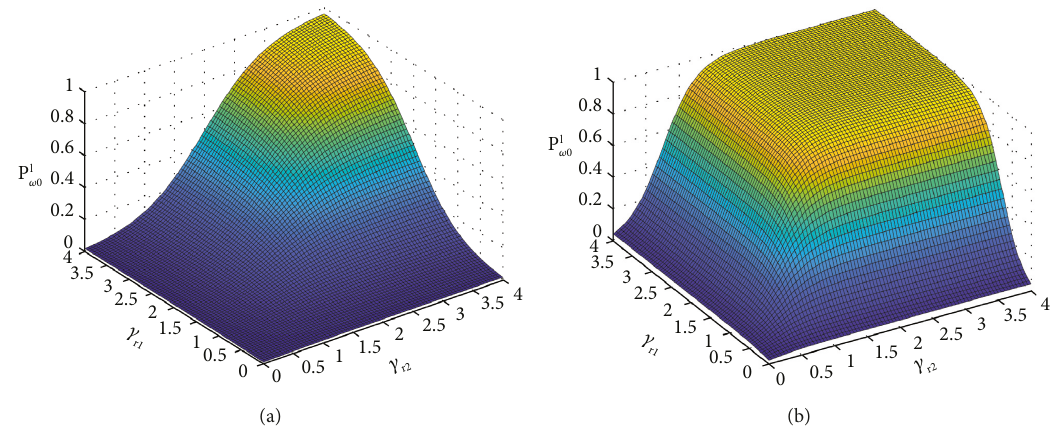
Figure 2: Probability of abandoning the trip when paths r